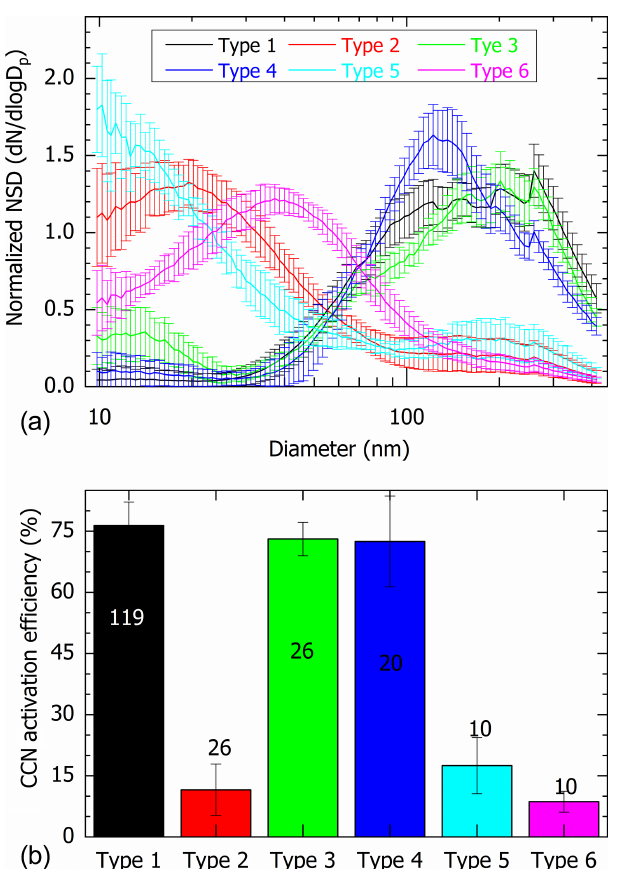
Figure 9. (a) Scatter plot between CCN number concentrations at 0.4% supersaturation (SS) with aerosol number concentration (CN) for particles size larger than 50, 100 and 150nm. (b) Vari- ation in regression coefficients (slope and R 2 ) estimated for CCN at 0.4% supersaturation with aerosol number concentration at dif- ferent size ranges. The N 50 indicate aerosol number concentration above